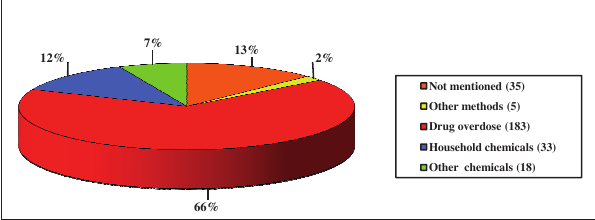
Fig. 2. Methods used in attempted